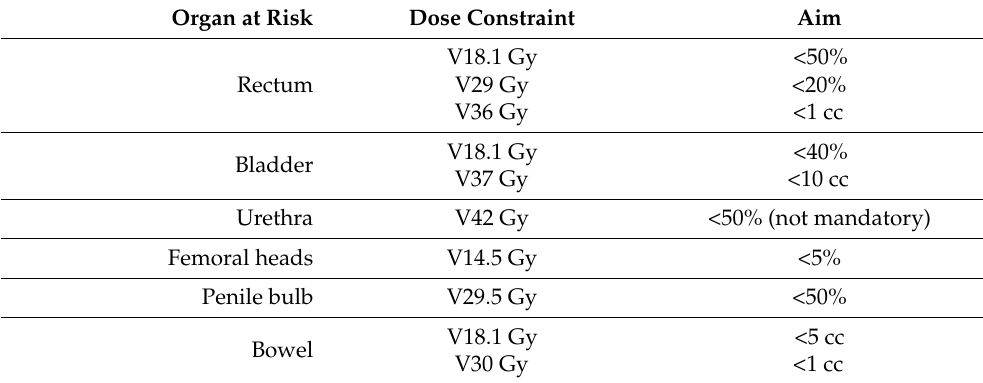
Figure 1. An example of radiotherapy treatment plan with PSMA imaging ( A ), MRI imaging ( B ) and Cyberknife R treatment volumes and isodose lines ( C ). Table 1. Main dose constraints